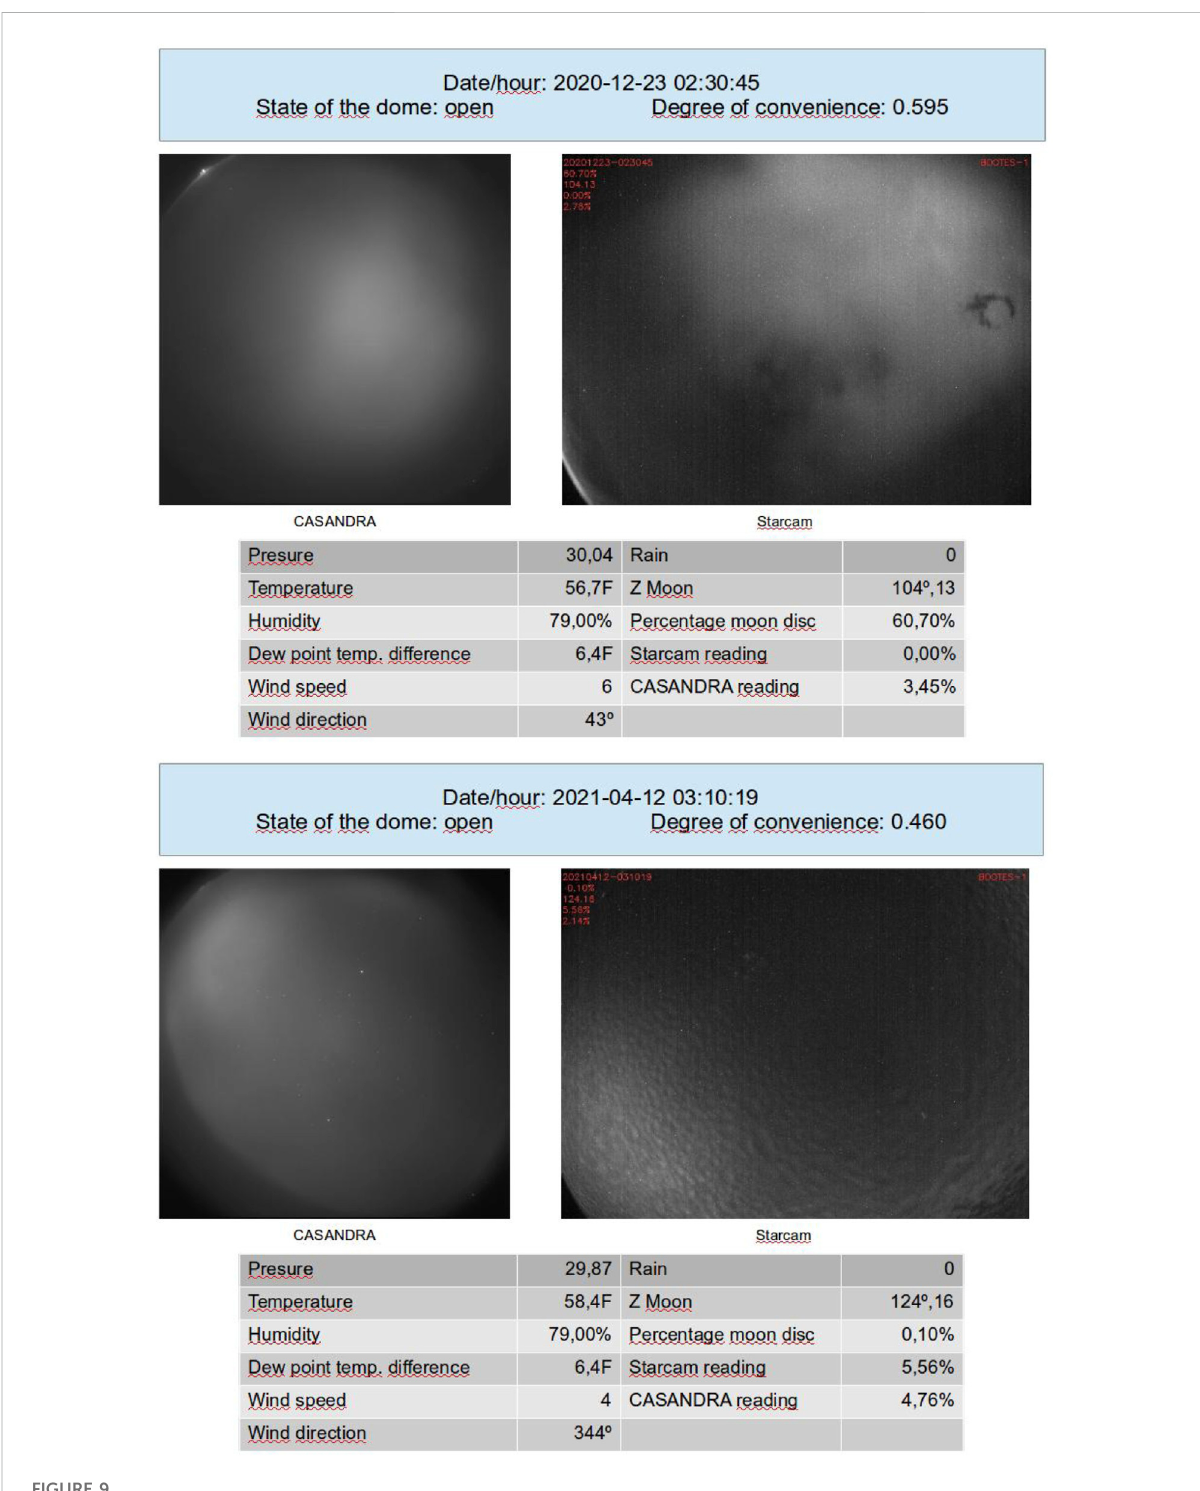
FIGURE 9 Dome was open, but the degree of convenience indicated that it could have remained